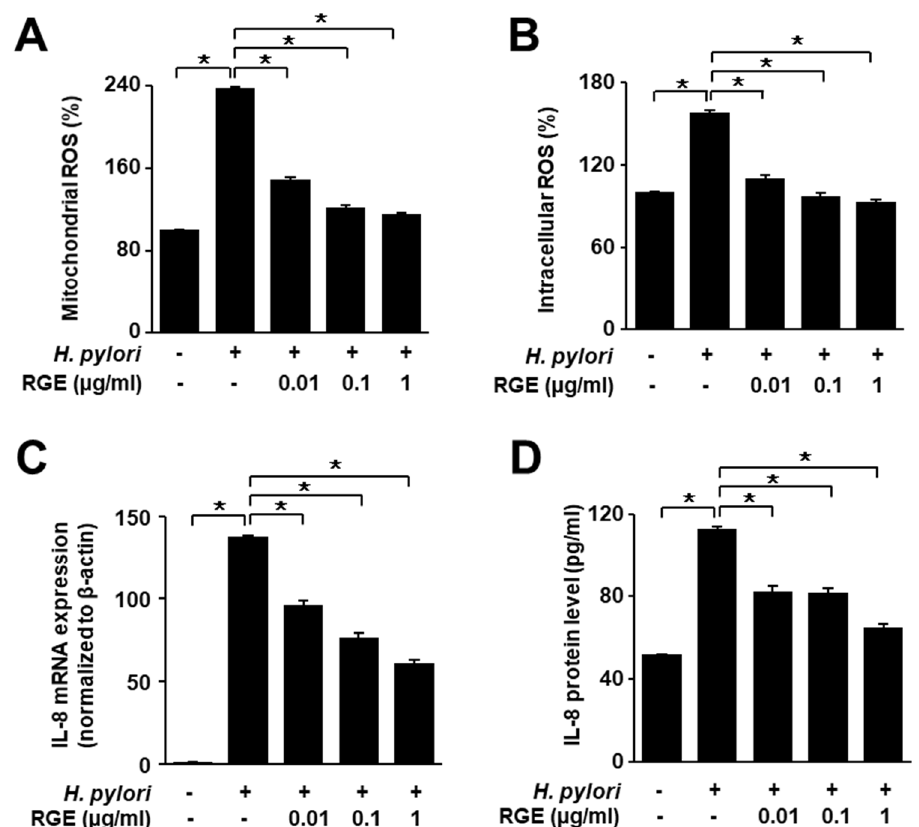
Figure 3. RGE suppresses the increases in ROS levels and IL-8 expression in H. pylori -infected AGS cells. The cells were pretreated with the indicated concentrations of RGE for 1 h and then infected with H. pylori for 1 h ( A , B ), 4 h ( C ), or 24 h ( D ). ( A ) Intracellular ROS was measured by dichlorofluorescein diacetate analysis. Intracellular ROS level in the untreated and uninfected cells was set at 100%. ( B ) Mitochondrial ROS was measured using MitoSOX. The mitochondrial ROS level in the untreated and uninfected cells was set at 100%. ( C ) IL-8 mRNA expression was quantified using real-time polymerase chain reaction (PCR) and normalized to β -actin. ( D ) IL-8 levels in the culture medium were assessed by enzyme-linked immunosorbent assay (ELISA). * p < 0.05.